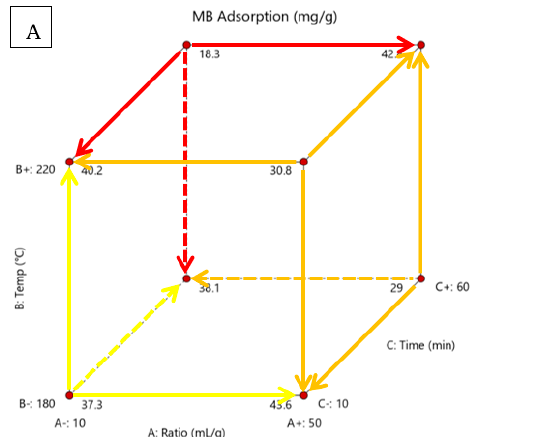
Figure 6. Cubic display of the effect of process temperature, solution ratio and residence time on ( A ) MB adsorption and ( B ) water adsorption, with highlighted relationships and direction of